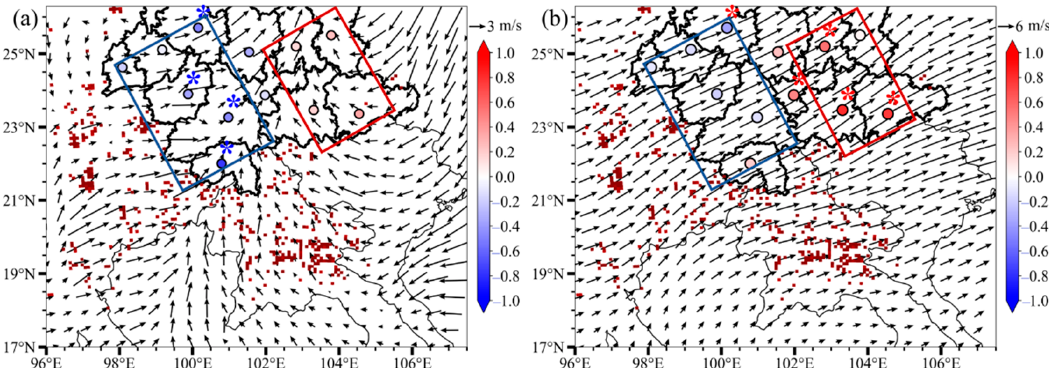
Figure 6. Spatial distribution of correlation coefficients (R) between surface PM 2.5 concentrations and ( a ) 10 m wind speed and ( b ) 700 hPa wind speed in sites over YP (scatters), and distribution of averaged ( a ) 10 m wind fields and ( b ) 700 hPa wind fields during 24–26 March 2017. The blue and red rectangles in both ( a , b ) represent SR and RR, respectively. The red dots are the same as in Figure 2b. The “*” indicates R passed the 99% confidence level.